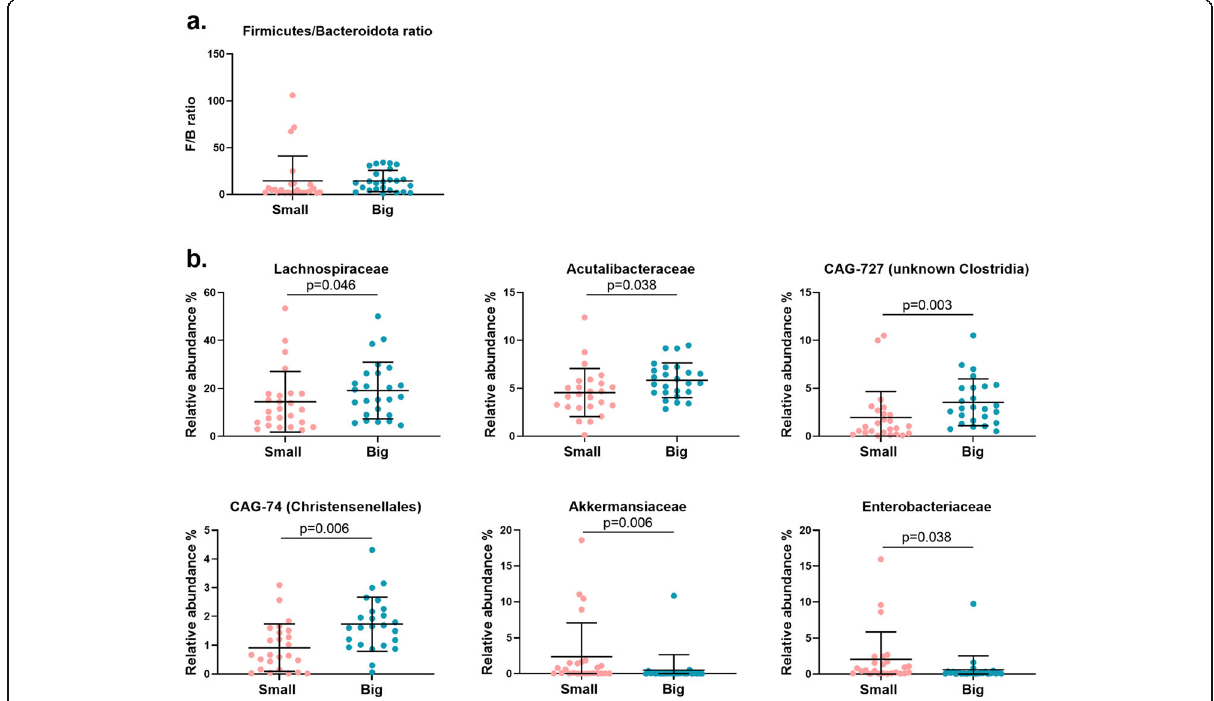
Fig. 3 a Firmicutes / Bacteroidota ratio of Big and Small broiler chickens ( p > 0.05; t-test on log2-transformed data). b Differentially abundant families between Small and Big chickens. Differences were tested by calculating the fold change of log2-transformed relative abundances of Big relative to Small. Solid lines indicate mean with